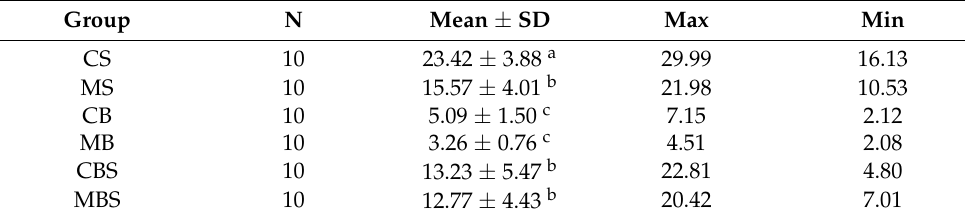
Table 1. Shear bond strength (SBS) values of each group (Mpa).